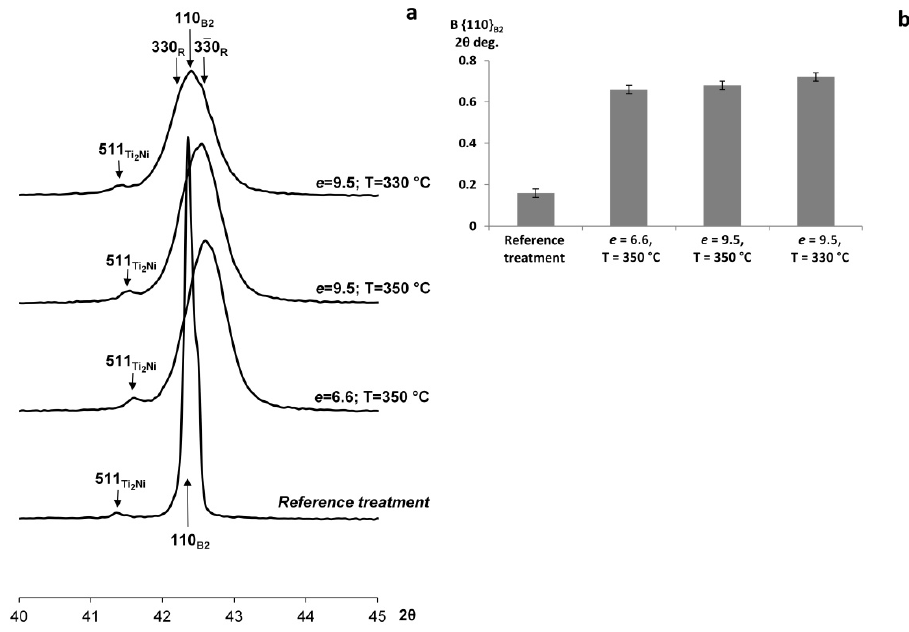
Figure 3. X-ray line{110} B2 profiles ( a ) and FWHM ( b ) of NiTi at room temperature after various